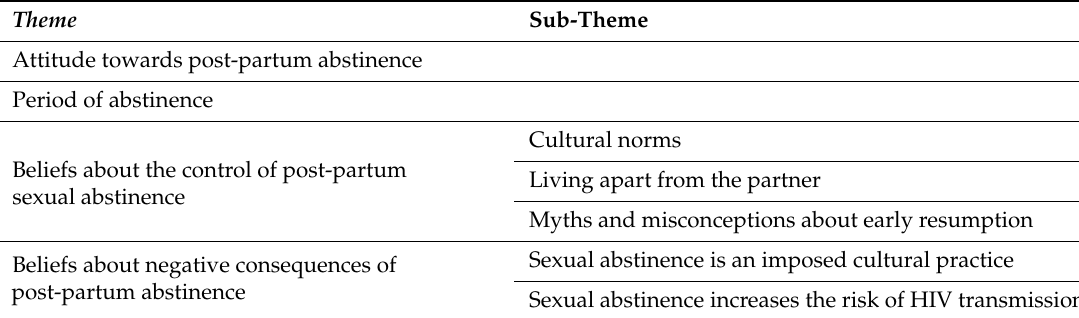
Table 3. Theory of Planned Behavior (TPB) construct